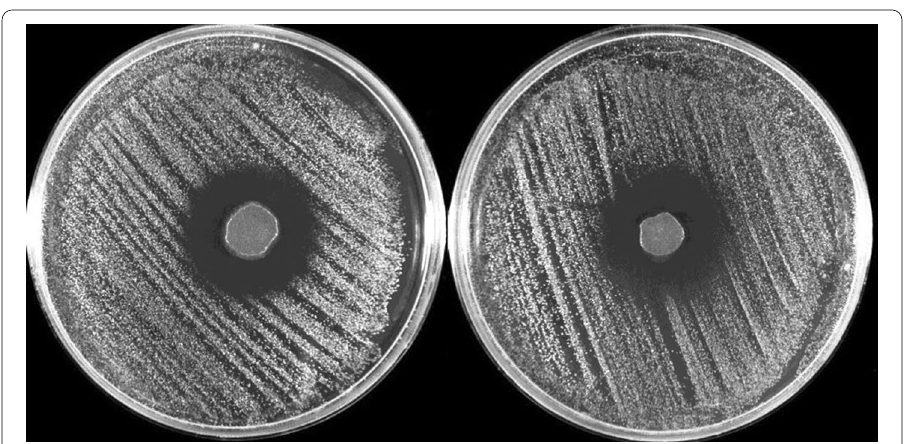
Fig. 1 Antimicrobial effects of Glubran Tiss 2 and SecurePortIV on S. epidermidis after 24